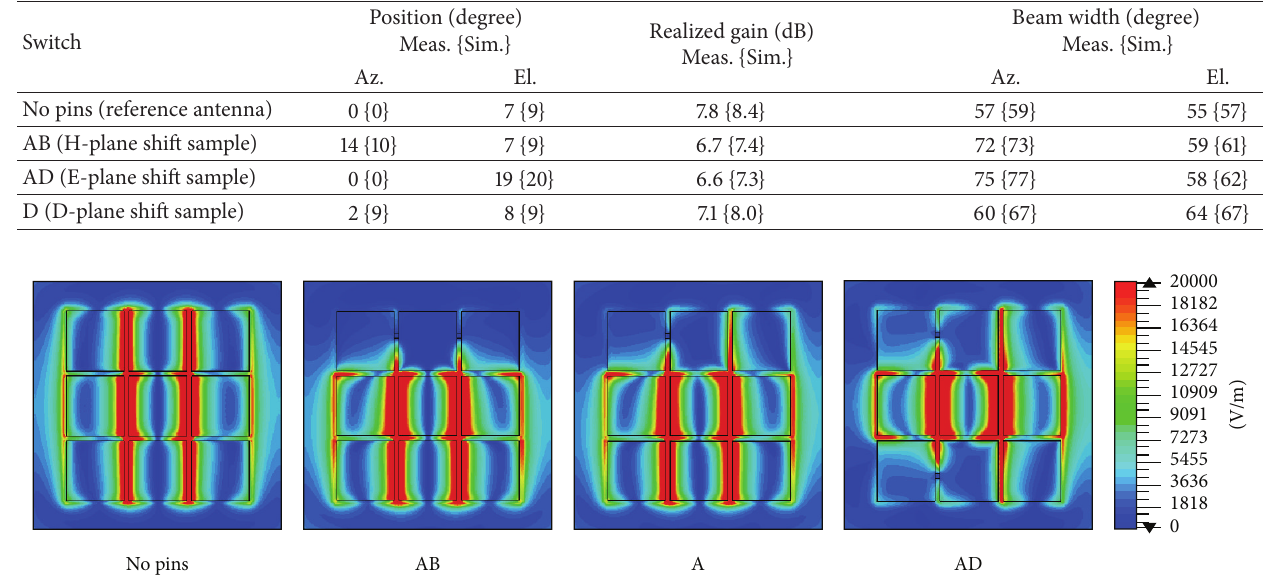
Figure5:Simulatedabsolutevalueoftheelectricfielddistributionat60 GHzattheantennatopsurfaceforthereferenceantennaandantennas with different beam shift configurations with 𝑝 = 0.5 mm. The total antenna substrate size is 5 mm by 5 mm.